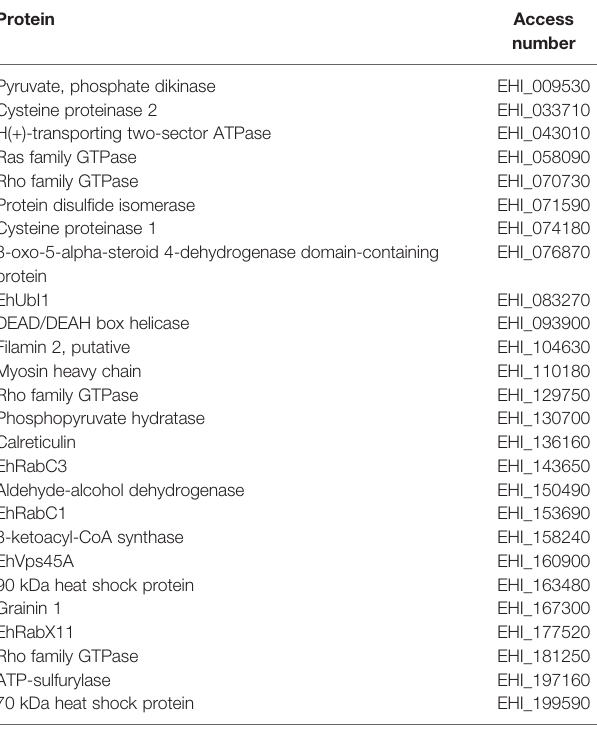
TABLE 3 | Proteins associated with motility**. Protein Access Pyruvate, phosphate dikinase